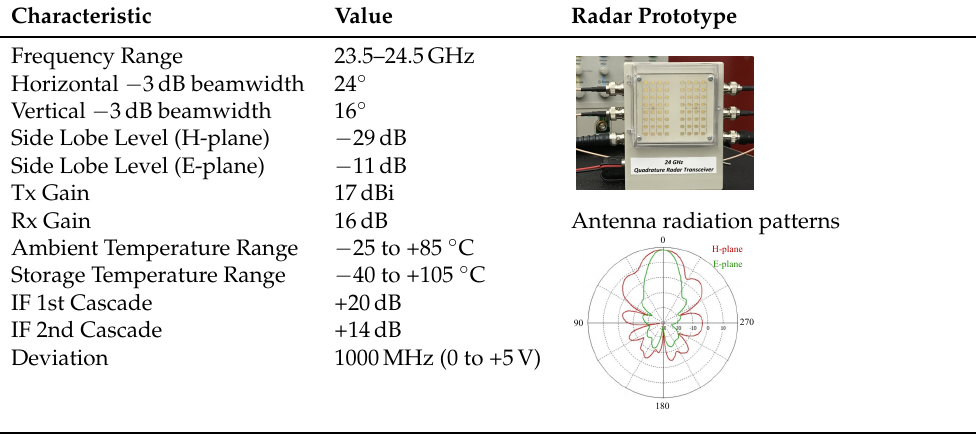
Table 1. 24GHz radar sensor parameters and prototype